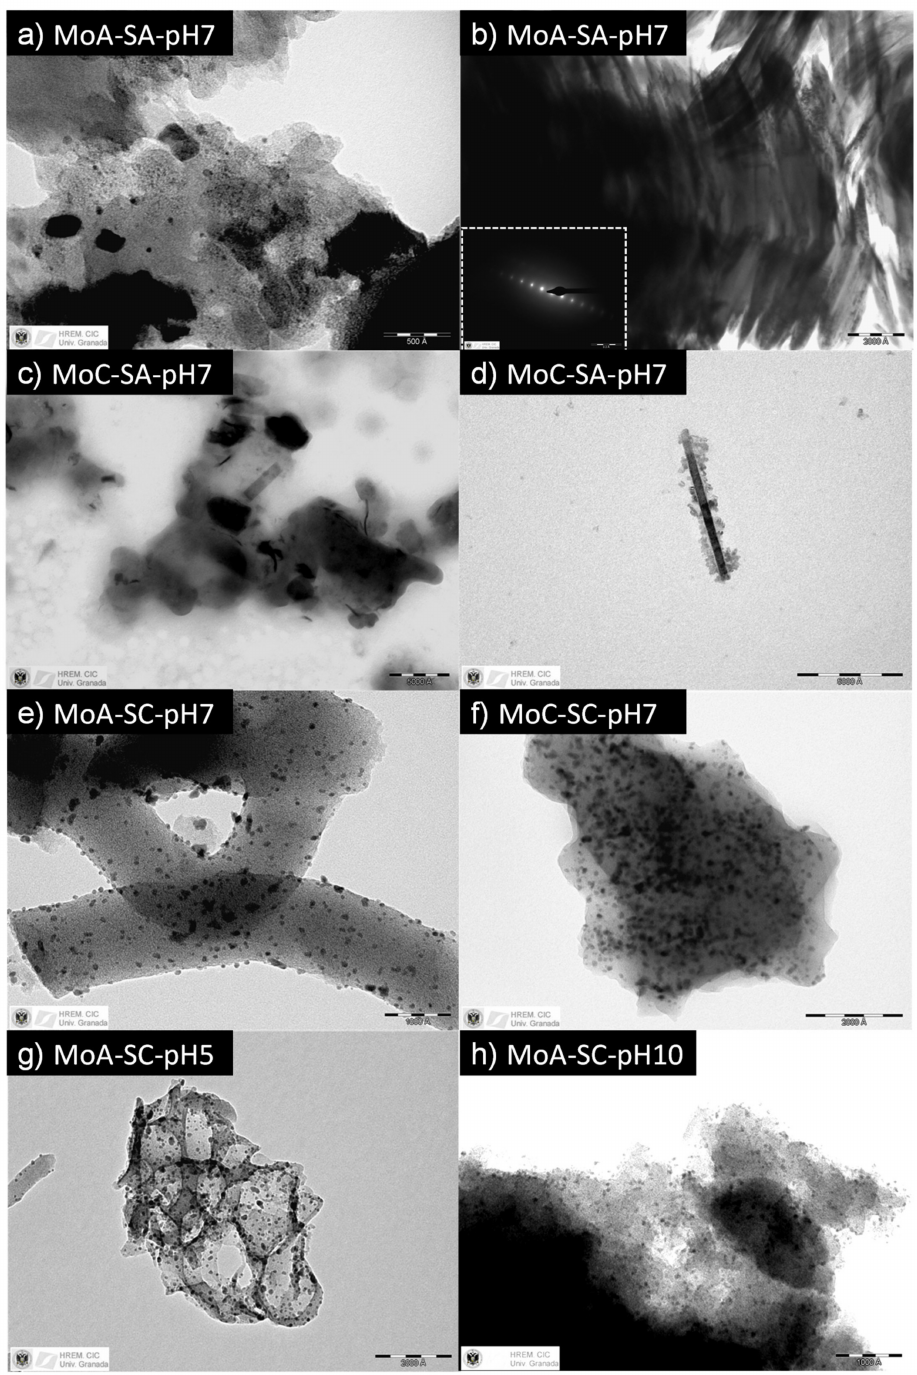
Figure 7. HRTEM images showing a high dispersion of metallic nanoparticles on the di ff erent carbon